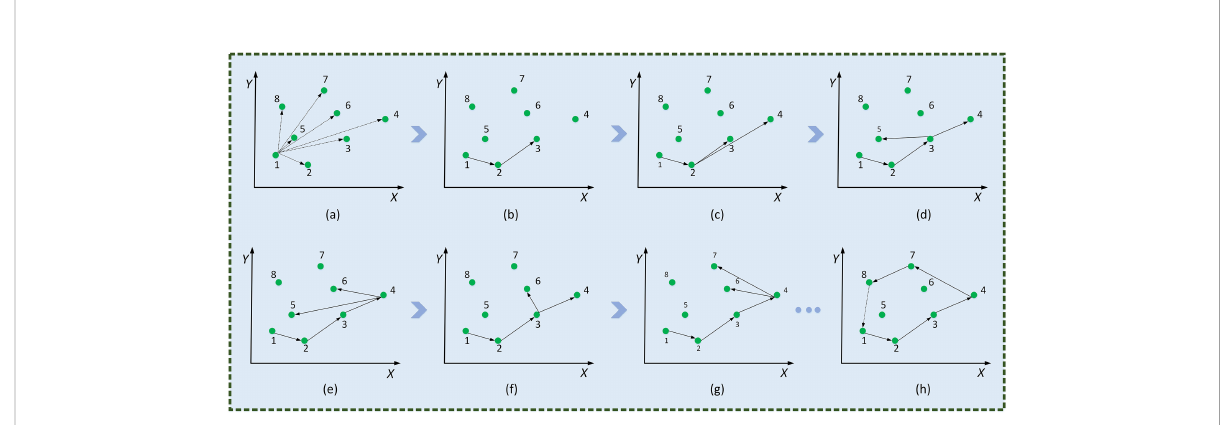
FIGURE 9 Minimum convex polygonal construction diagram. Traverse coordinate points (A) , P 1 P 2 (cid:4)(cid:4)(cid:4) ! (cid:4)(cid:4)(cid:4) ! > 0, deposit P (C) , P 3 P 4 (cid:3) P 3 P 5 smallest convex polygon (H)